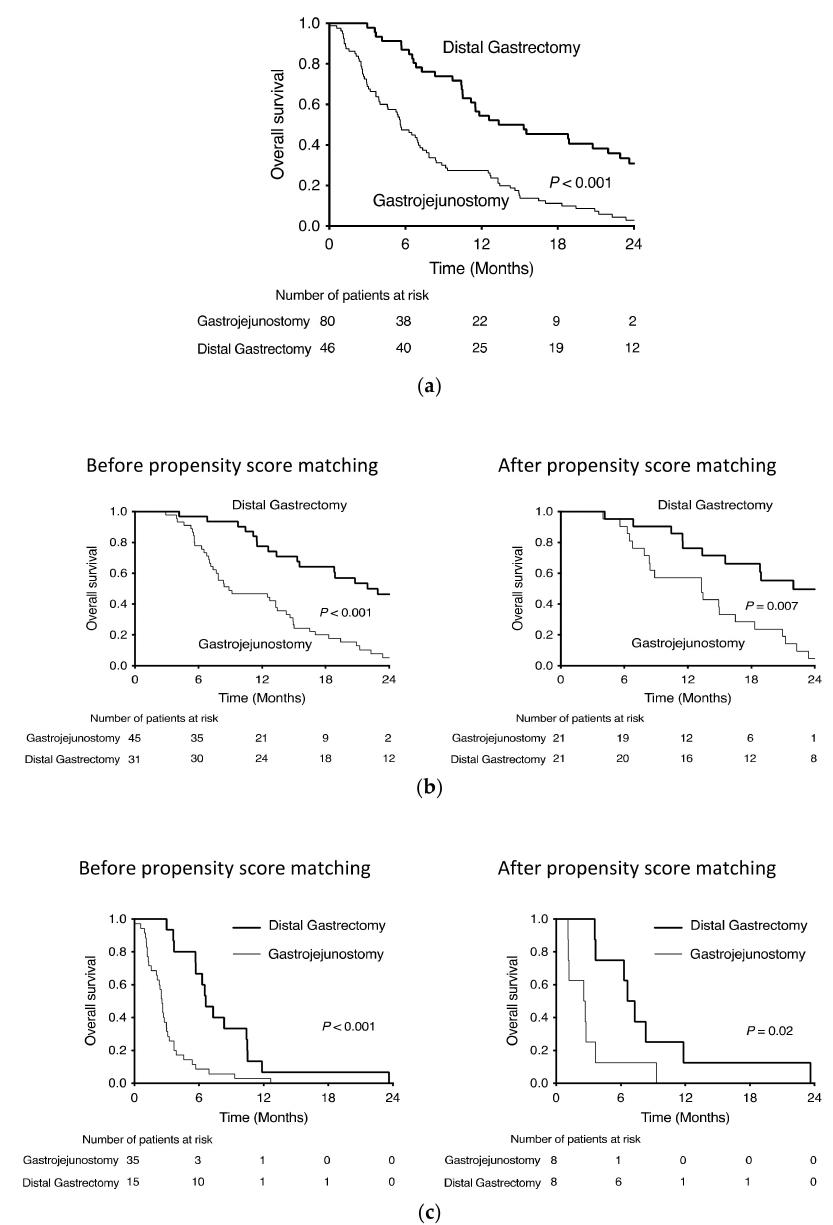
Figure 1. Kaplan–Meier survival curves of distal gastrectomy and gastrofejunostomy for stage IV gastric cancer ( a ) all cases, ( b ) with chemotherapy and ( c ) without chemotherapy. Of the 76 patients who received postoperative chemotherapy, 31 underwent distal gastrectomy, and 45 underwent gastrojejunostomy. Performance Status (PS) was better and preoperative obstruction, NLR, distant lymph node metastasis, and use of laparoscopic approach were higher in the gastrojejunostomy group (Table 3). After propensity score matching with PS, obstruction, NLR, distant lymph node metastasis and surgical approach for 76 patients who received postoperative chemotherapy, distal gastrectomy and gastroje- junostomy matched 21 cases each (Table 4). The overall survival of the two groups before and after propensity score matching is shown in Figure 1b. After matching, the median survival time was 13.3 months in the gastrojejunostomy group and 22.0 months in the distal gastrectomy group. The 24-month survival rate was 4.8% in the gastrojejunostomy group and 49.7% in the distal gastrectomy group (HR 0.406, p =